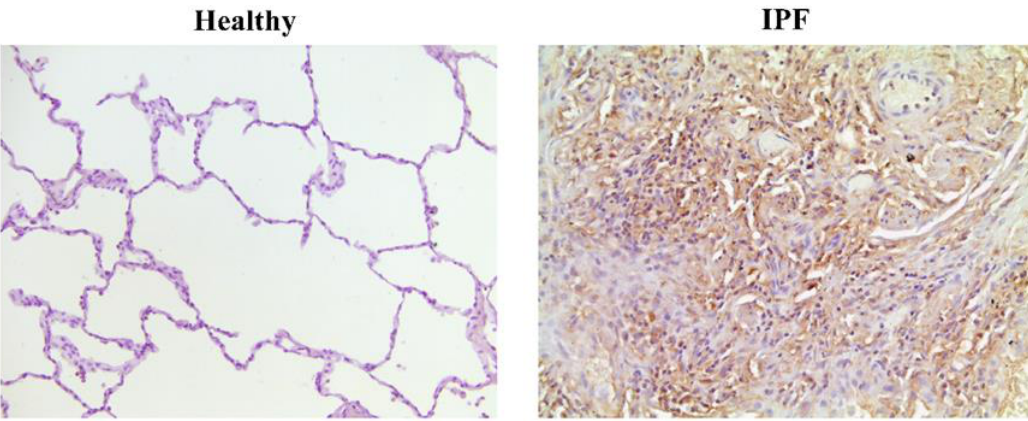
Figure 5. MUC1 expression in lung tissue from healthy and IPF subjects. Immunohistochemistry of MUC1 in lung tissue from healthy and IPF patients. In IPF patients, MUC1 expression is observed at hyperplastic alveolar type II cells and fibrotic areas. However, MUC1 is expression is almost undetectable in healthy subjects.